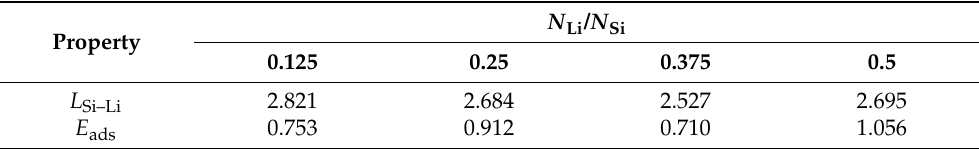
Table 1. Average Si–Li length and adsorption energy of Li for different quantities of Li atoms in the system.